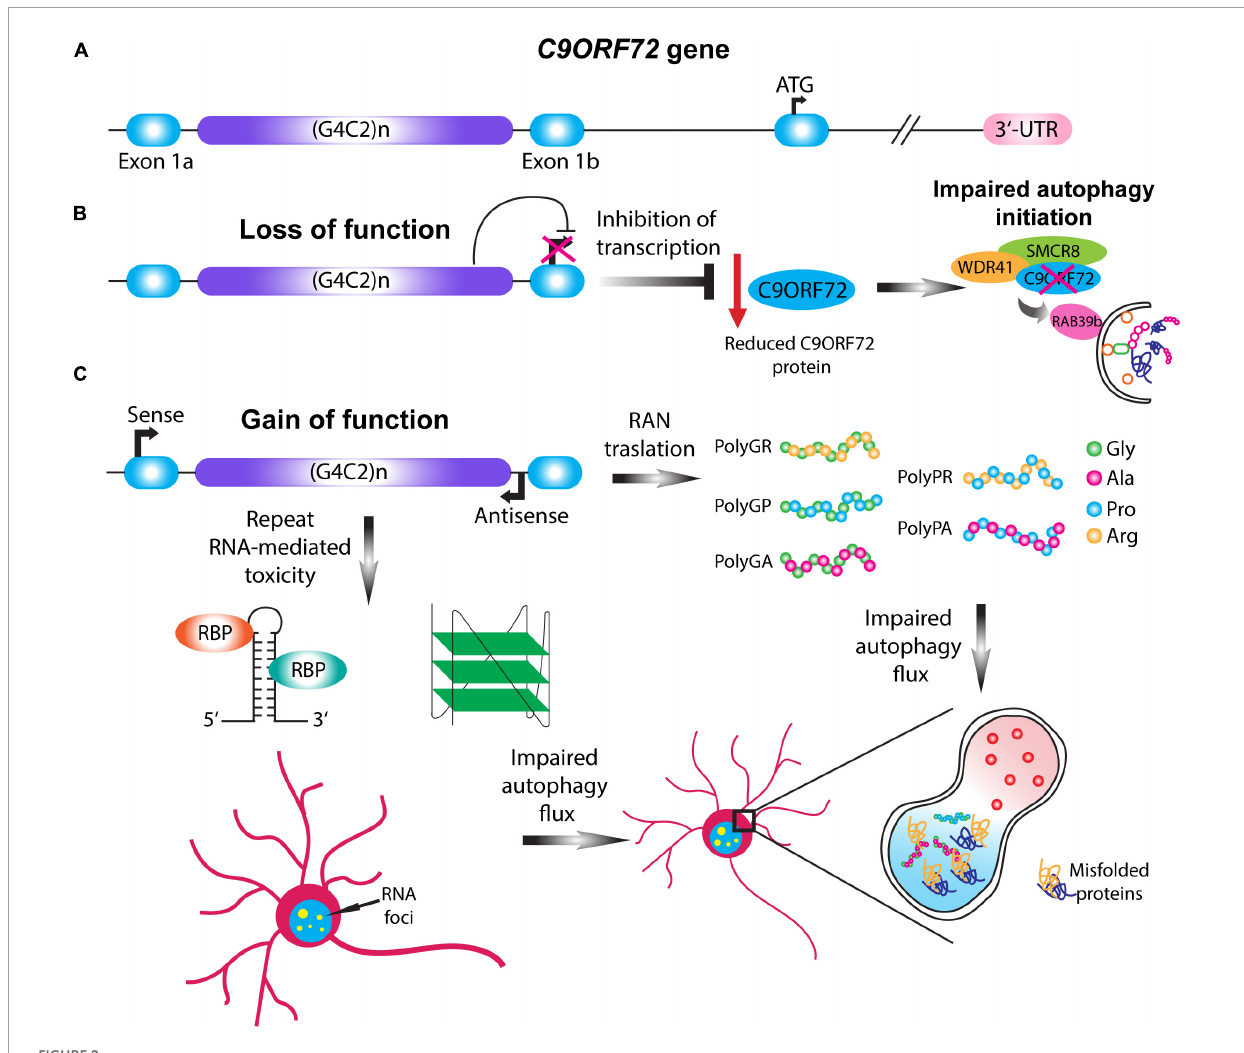
FIGURE2 C9ORF72 loss and gain of function mechanisms impair autophagy. (A) Schematic illustration of the C9ORF72 gene. C9ORF72 -ALS-FTD is characterized by a G4C2 hexanucleotide repeat expansion between exon 1a and exon 1b, which in patients can range up to thousands of repeats. (B) Haploinsufficiency of C9ORF72 gene causes the loss of function of the C9ORF72 protein by transcription inhibition. Given its importance in the initial steps of phagophore formation, reduction in the C9ORF72 protein impairs autophagy initiation, destabilizing WDR41 and SMCR8 complex. (C) Two pathological mechanisms involving the gain of function of the HRE gives rise to RAN translation and repeat-linked RNA mediated toxicity. In the case of RAN translation, the HRE can be translated in a sense or antisense manner giving rise to five different dipeptide repeats proteins (DPRs): PolyGA, PolyGP, PolyGR, PolyPR, and PolyPA. In the case of RNA-mediated toxicity the translated HRE can form higher order structures that sequester different RNA binding proteins, and thus forming RNA foci. The gain of function mechanisms can impair the autophagic flux and the formation of the autolysosome, leading to the accumulation of misfolded